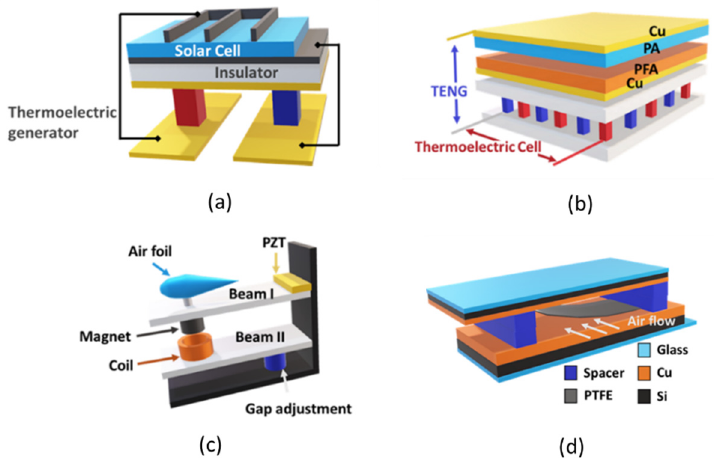
Figure 4. Selected examples of hybrid converters including: ( a ) photovoltaic/thermoelectric generator (see [41]); ( b ) triboelectric/thermoelectric generator (see [42]); ( c ) piezoelectric/electromagnetic generator (see [43]); and ( d ) photovoltaic/triboelectric generator (see [44]).